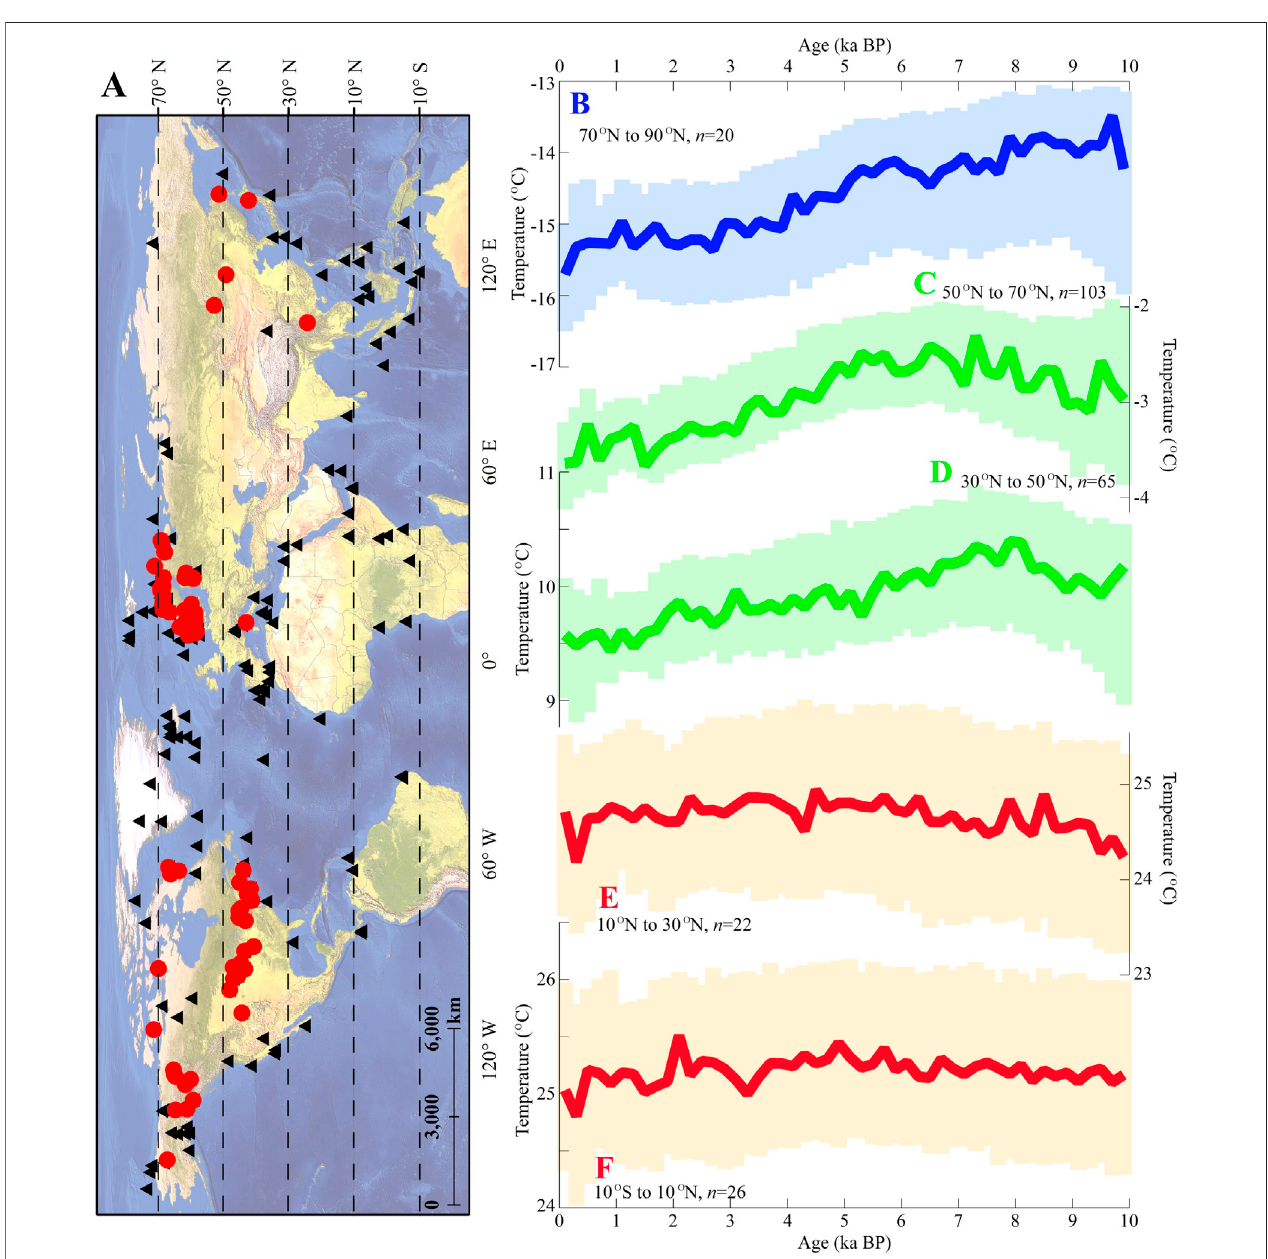
FIGURE 5 | Spatial distribution of the adopted records (the pollen records are represented by red dots) (A) and the corresponding stacked Holocene temperature records for different latitudinal bands (B – F) ; Routson et al., 2019.